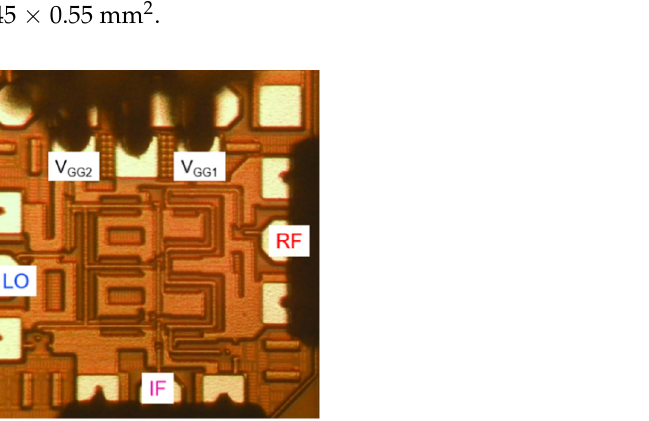
Figure 16a,b show the on-wafer probing measurement setups of the fabricated mixer.